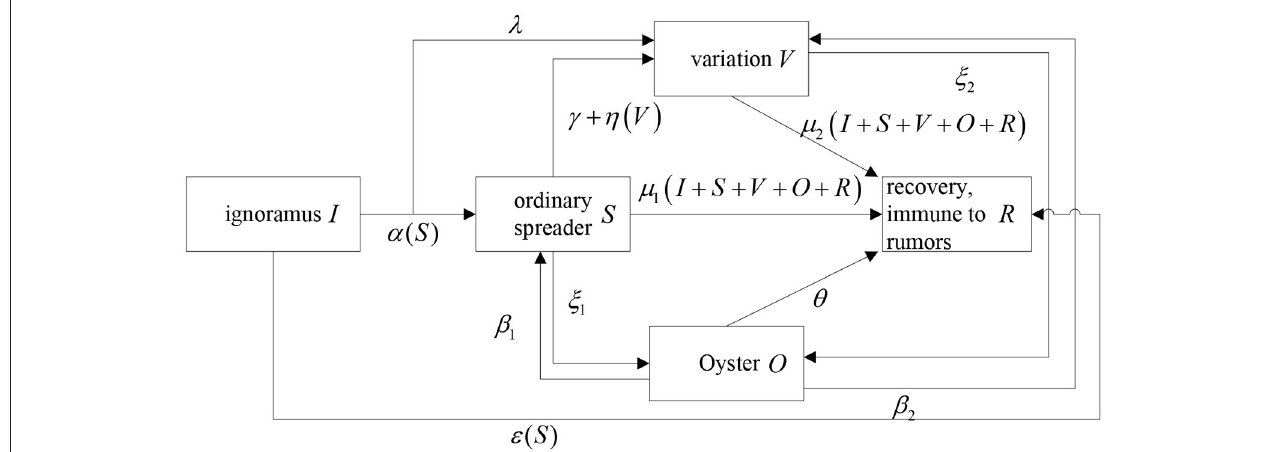
FIGURE 2 | Model structure